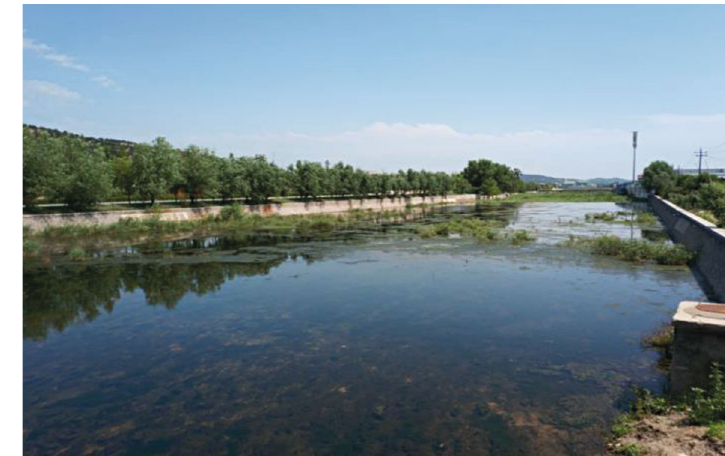
Figure 2: Daedong River.